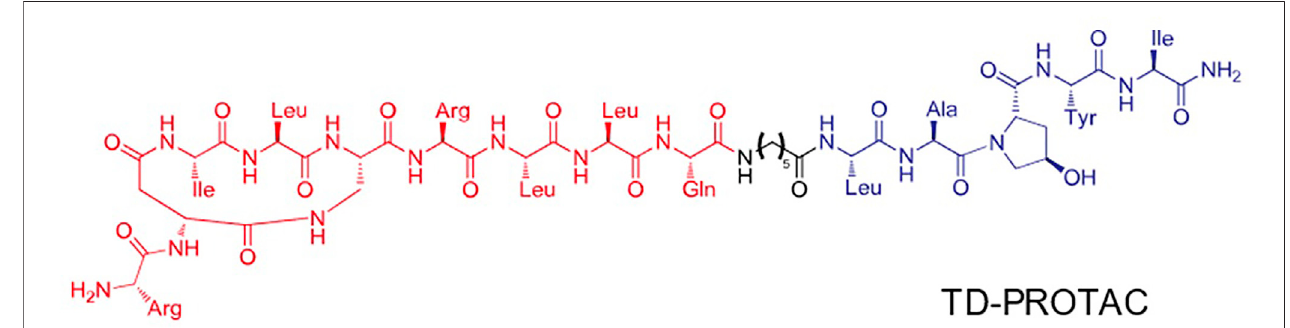
FIGURE 1 | Structure-based design of TD-PROTAC. The red part indicates the sequence targeting ER α , the black part indicates the linker and the blue part indicates the ligand binding to the von Hippel-Lindau (VHL) E3 ubiquitin ligase.